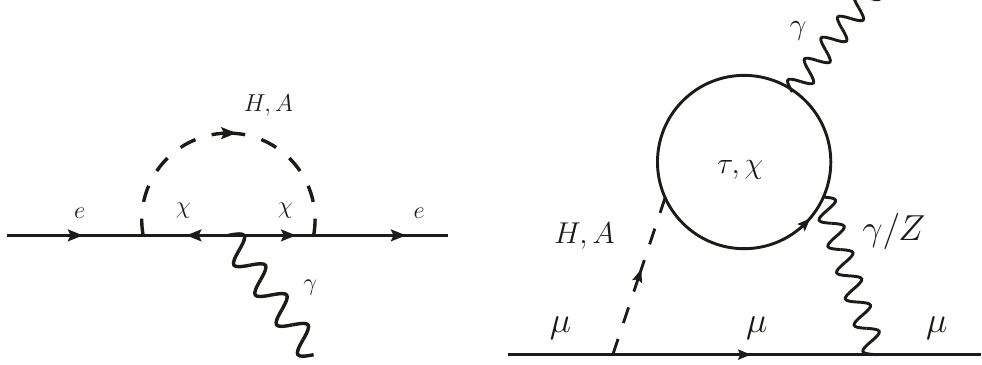
Figure 1 . Left figure shows electron ( g − 2) dominant contribution from the chirality flip of the heavy leptons and the right figure is a representative two-loop Barr-Zee diagram which explain the muon ( g − 2) . Here χ denotes the vector-like